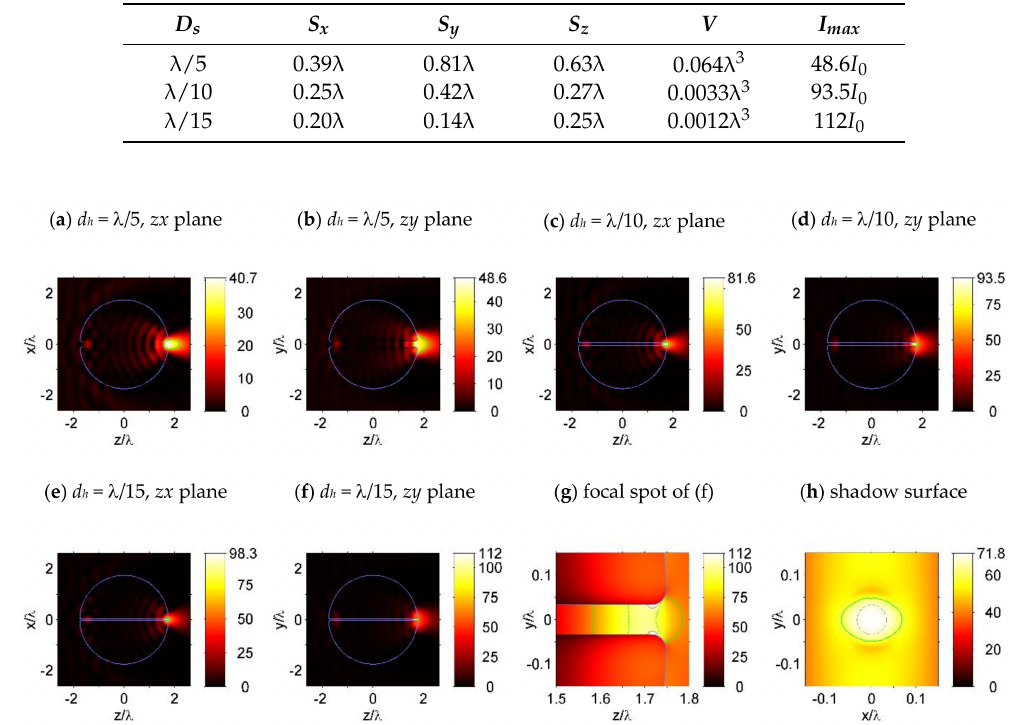
Table 2. Light focusing properties of the simulated nanohole-structured microspheres with a sphere diameter of D s = 3.5 λ , refractive index of n = 1.5, and a through hole of d h = λ /15 in diameter.